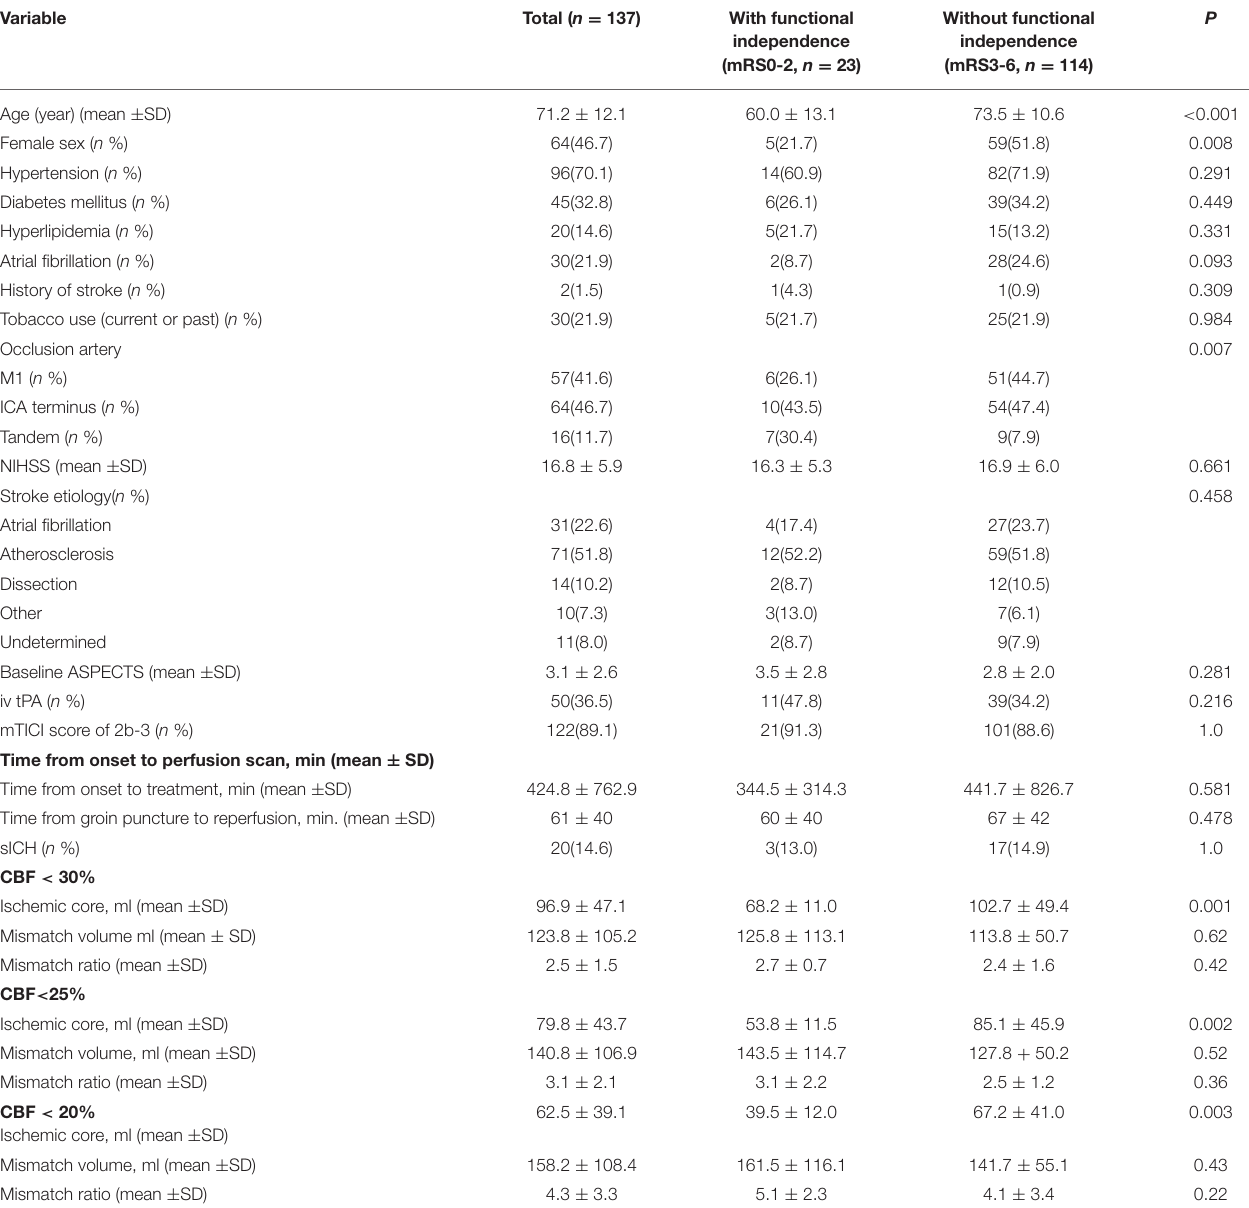
TABLE 1 | Baseline clinical characteristics of different groups.